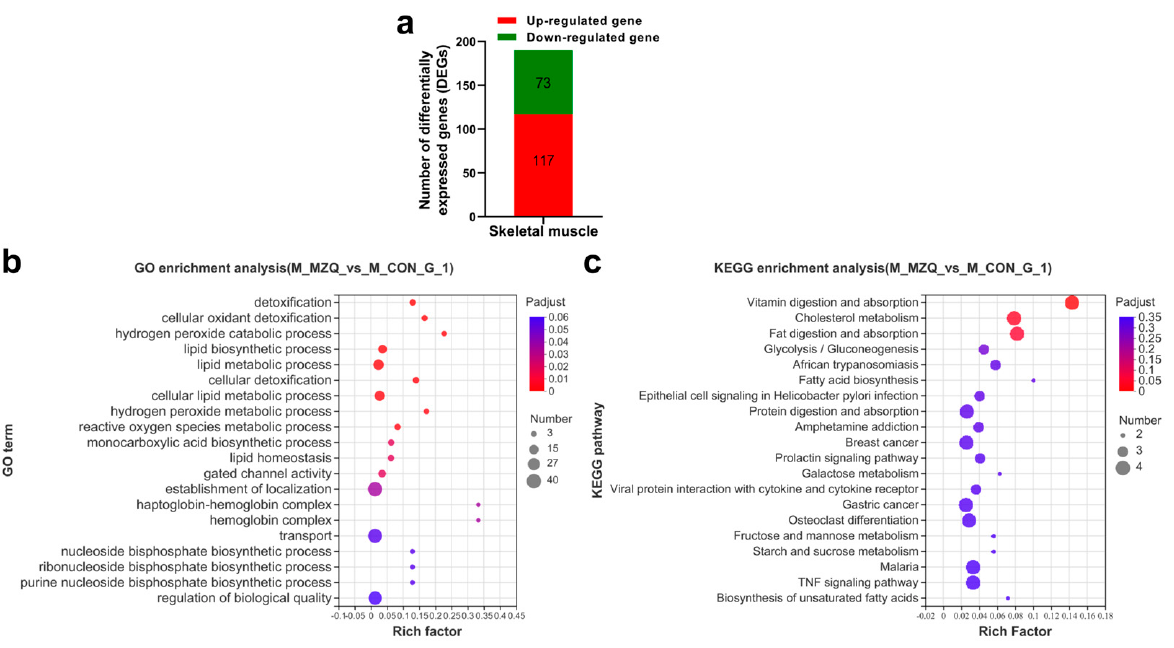
Figure 7. Transcriptomic analysis of skeletal muscle. ( a ) DEGs between the ZQ-1 g and control. ( b ) Bubble plot of the enriched GO terms of skeletal muscle. ( c ) Bubble plot of the enriched KEGG pathways of skeletal muscle.